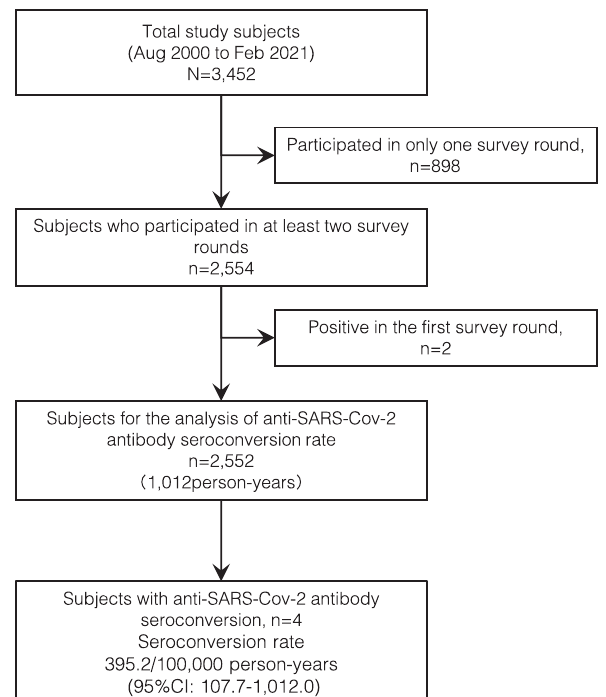
Fig. 4 Anti-SARS-Cov-2 antibody seroconversion rate in Hiro- shima Prefecture from August 2020 to February 2021 This fi gure shows the fl ow of the follow-up subjects on the study of anti-SARS-Cov-2 antibody seroconversion rate. From a total of 3,452 subjects who participated at least once in the three rounds of the study, 2,552 subjects were included in the analysis of anti- SARS-Cov-2 antibody seroconversion rate. Four subjects acquired anti-SARS-Cov-2 antibodies during the follow-up, indicating a se- roconversion rate of 395.2 persons per 100,000 person-years.